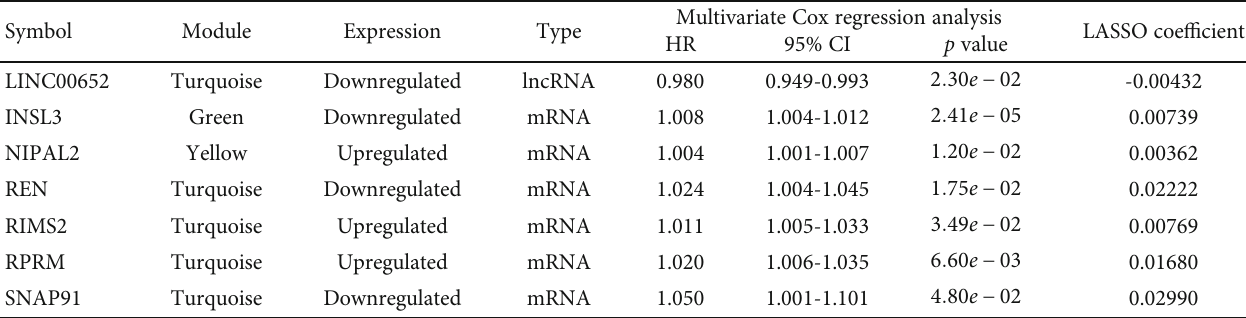
Figure 4: Identi fi cation of di ff erentially expressed module genes. (a) Heat map of di ff erentially expressed RNAs; (b) Venn diagram to show the overlap between di ff erentially expressed RNAs and module genes. Table 2: The optimal prognostic